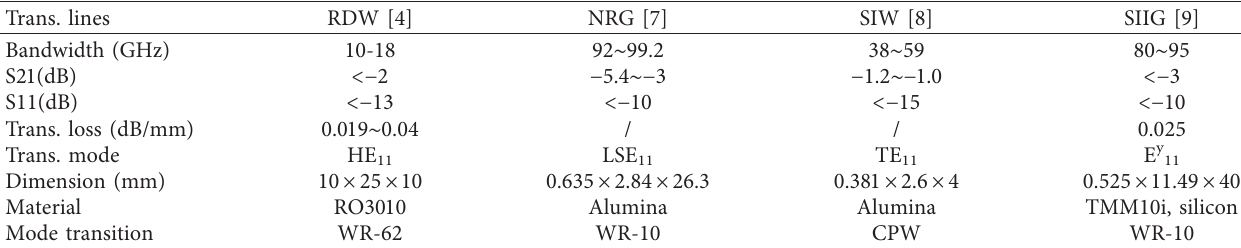
Table 1: Comparison of different structures.